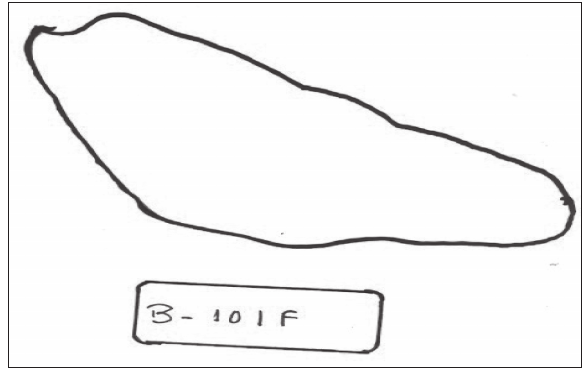
Figura 2 – Método planimétrico: digitalização da área da úlcera no acetato Fonte: Dados da pesquisa.